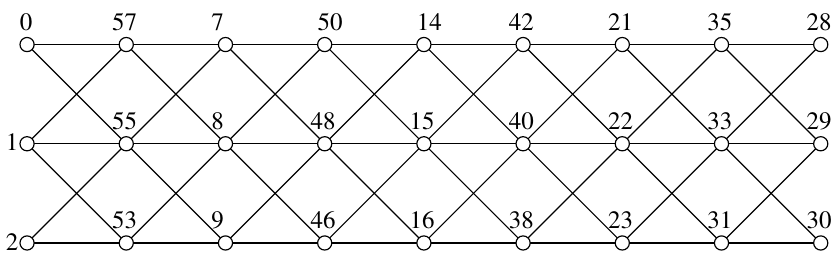
Figure 5: 2-divisible α -labeling of S